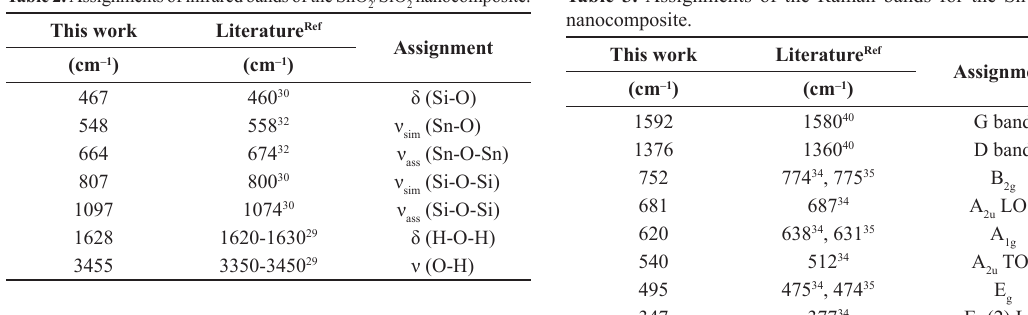
Figure 3. Spectra for the SnO Table 2. Assignments of infrared bands of the SnO